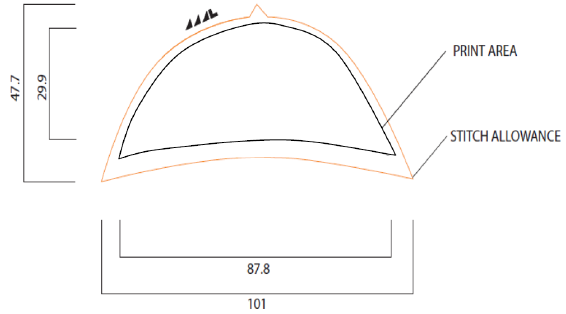
Figure 2. ( a ) Example of Bobux shoe with midsole removed; ( b , c ) Upper of the toe area showing the cross-section and layers of the shoe.